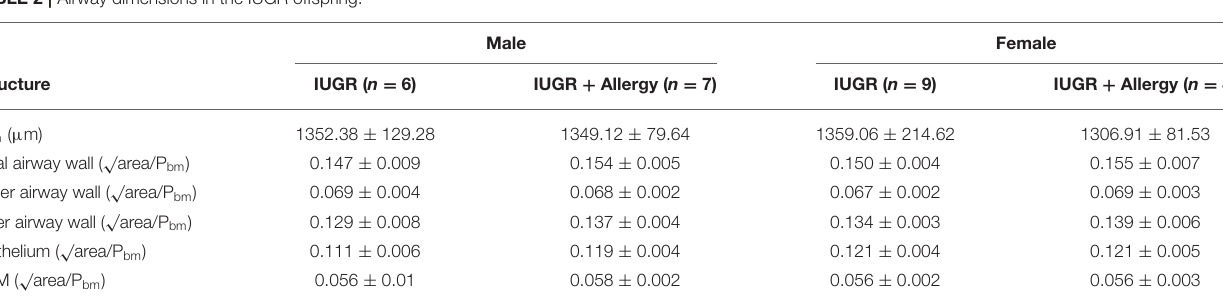
TABLE 2 | Airway dimensions in the IUGR offspring.